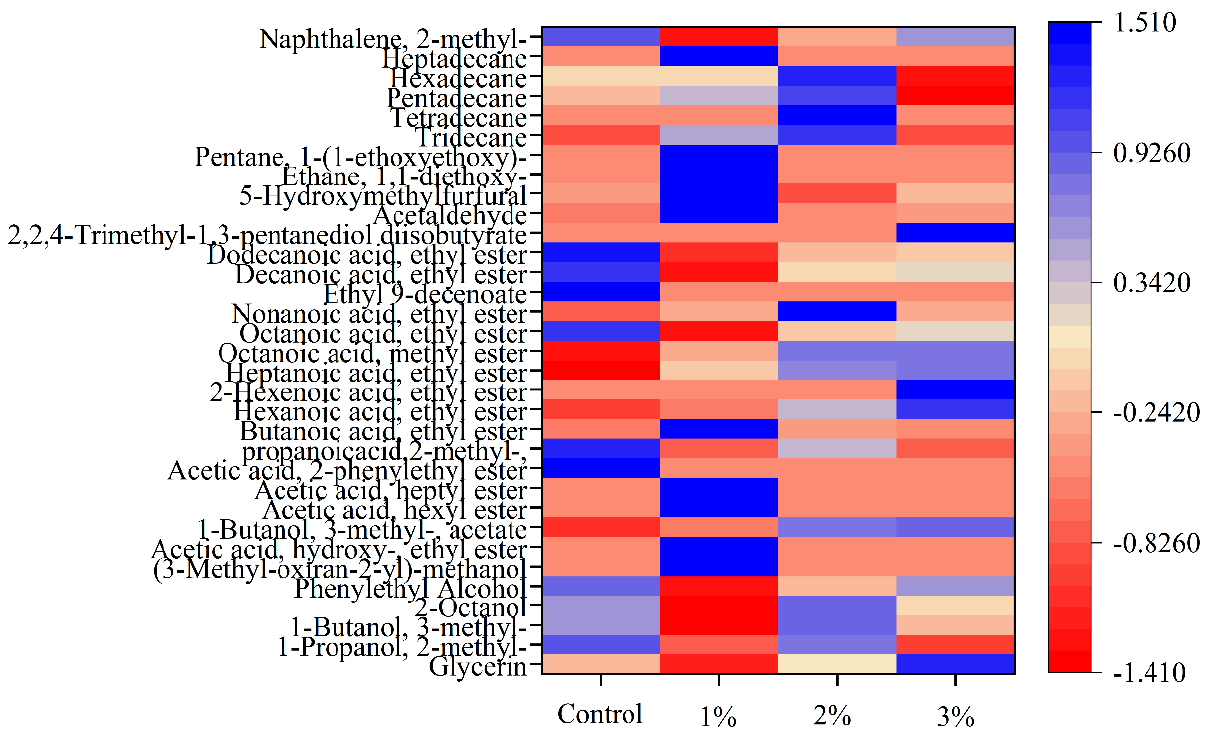
Figure 3. Heatmap showing the relative contents of volatile substances in the four fermented alcoholic beverages with the addition of mulberry leaf powder during fermentation. Control represents without the addition of mulberry leaves; 1, 2 and 3% ( w / v , g/mL dry weight) represent the added amount of mulberry leaf powder.